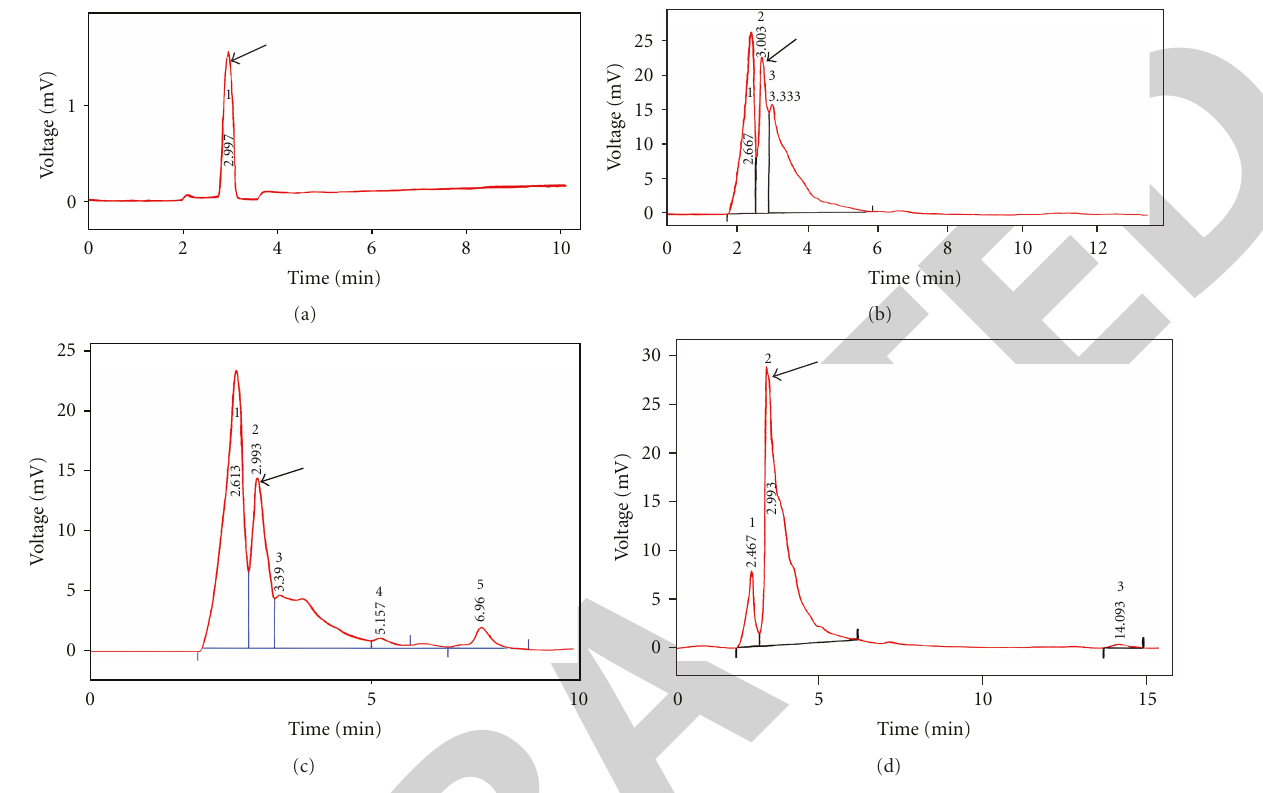
Figure 5: (a) Standard gymnemic acid; (b) in vivo leaf; (c) OPGRs MS + 2,4-D (1.5 mg/L) with KN (0.5 mg/L); (d) blue light treatment with